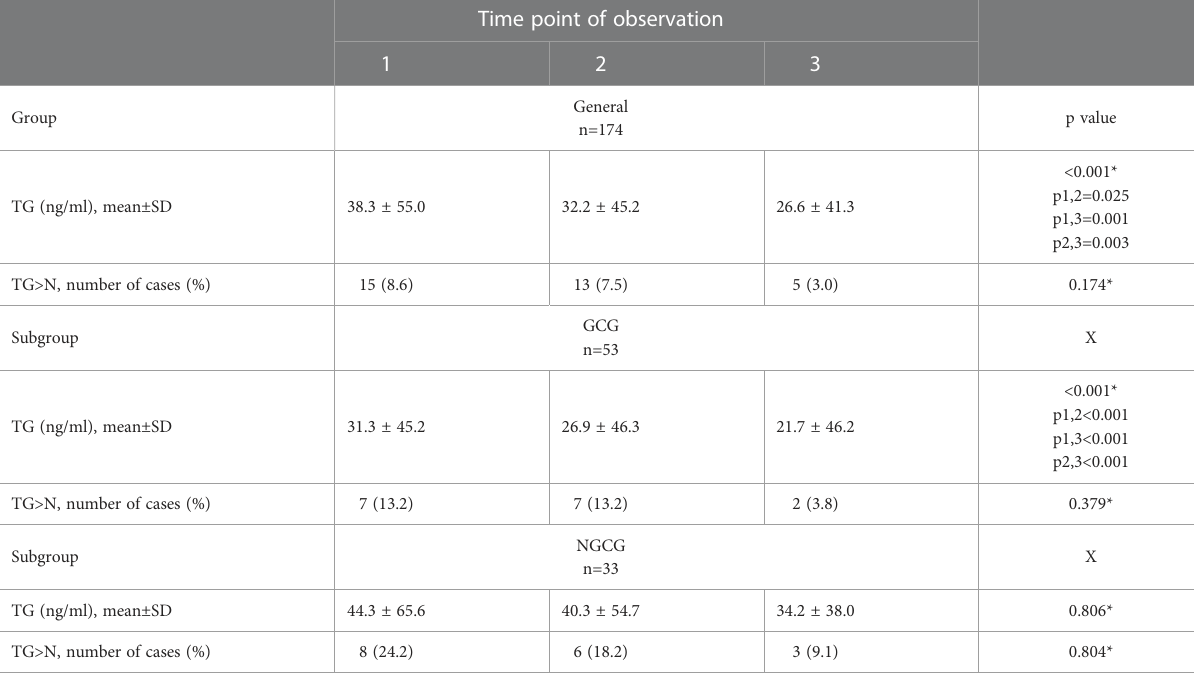
TABLE 2 TG concentration and the number of cases that exceeded the upper normal limit of TG concentration at three observation points in the general population and those treated versus those not treated with glucocorticoids.